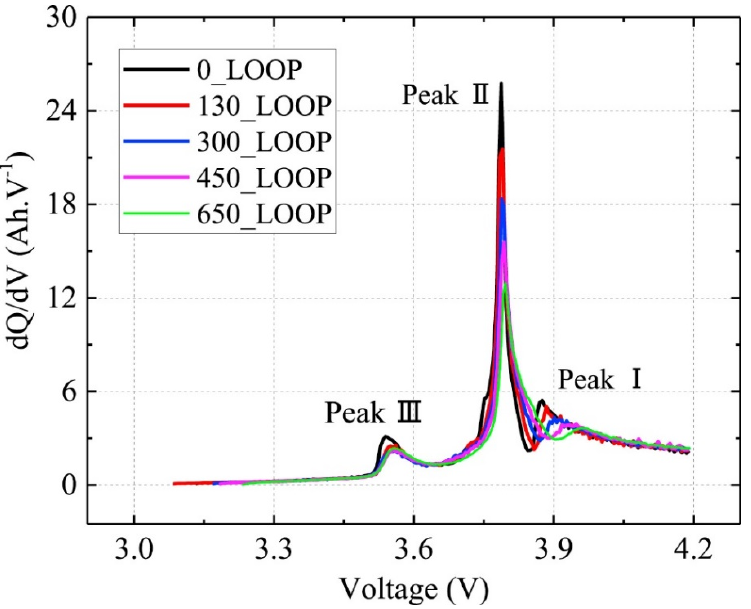
Figure 2. Incremental capacity curve of cycling at 0.05 C charging current [41]. Reprint with permission [41]; Copyright 2017, Elsevier.